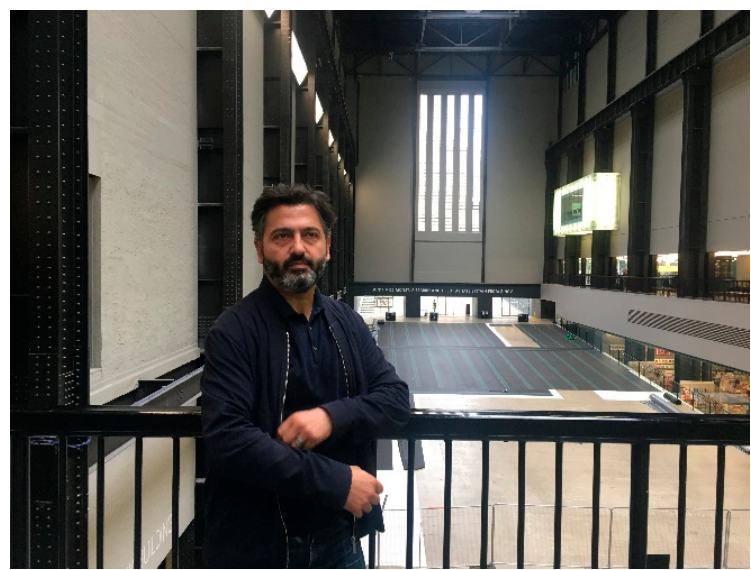
Figure 8. Hrair at the Tate Gallery, London. Photographs by the author.